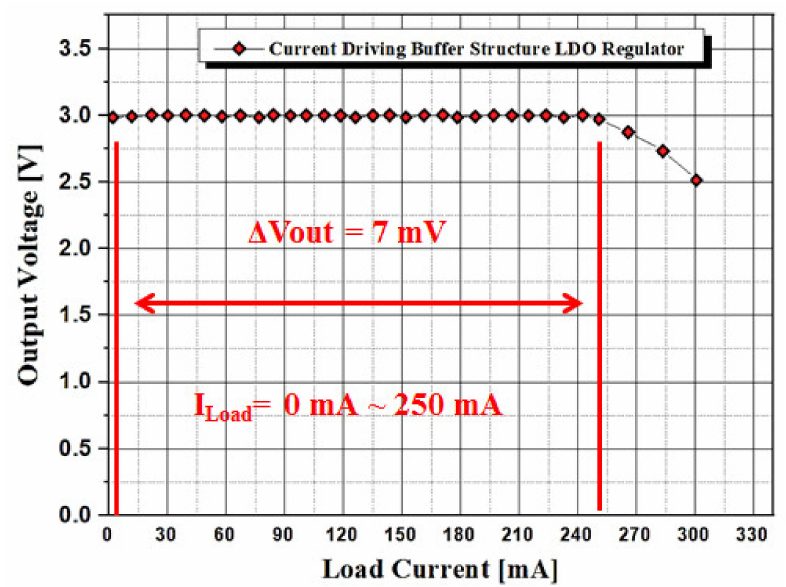
Figure 13. Load regulation of the proposed LDO